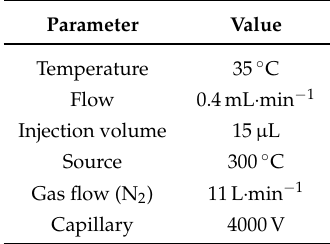
Table 6. LC parameters for quantification of